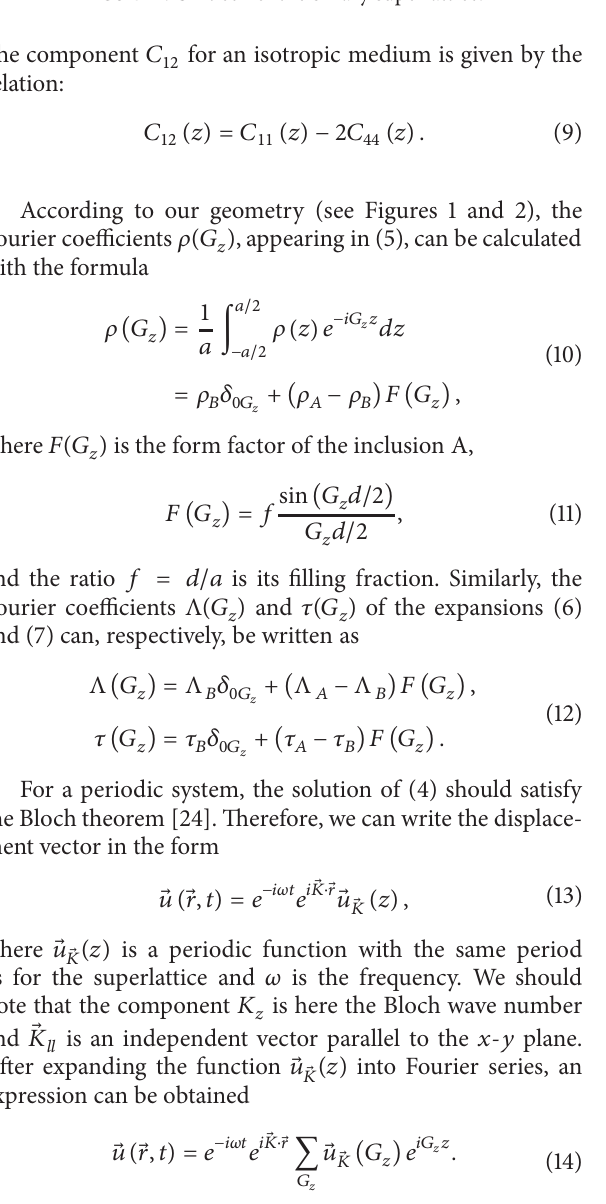
Figure 2: Unit cell of the binary